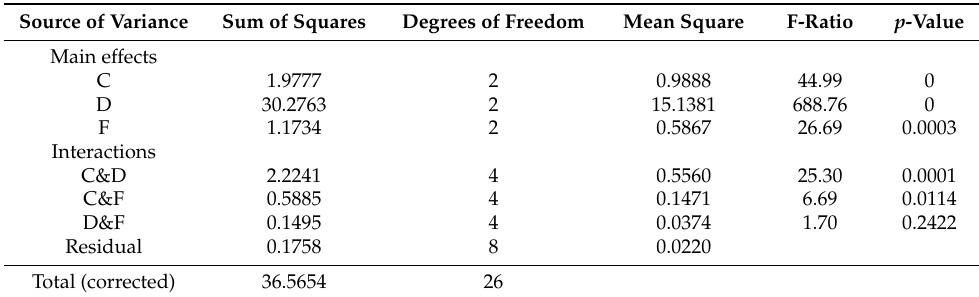
Table 4. Analysis of variance (ANOVA) test results on w i .